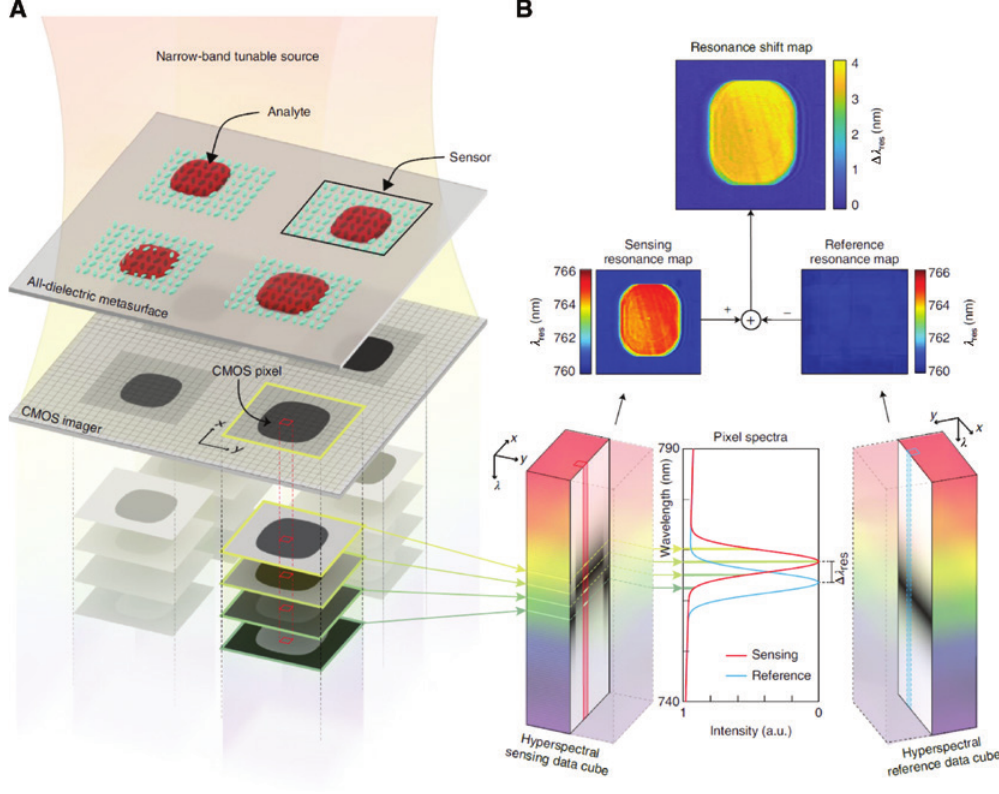
Figure 9: Principle of hyperspectral imaging-based biomolecule detection using all-dielectric metasurfaces. (A) Sketch of the hyperspectral imaging principle showing a representative dielectric metasurface sensor array illuminated with narrow-band tunable laser source. At each wavelength illumination, images are recorded by a CMOS camera (1608 × 1608 pixels) to create a hyperspectral data cube where each CMOS pixel captures high-resolution spectral information. (B) The hyperspectral data cube is processed to extract spatial resonance maps of each individual sensor. For biomolecule detection, the sensing and reference resonance maps are combined to create the resonance shift map, which conveys spectral shift information across the whole sensor. Reprinted with permission from